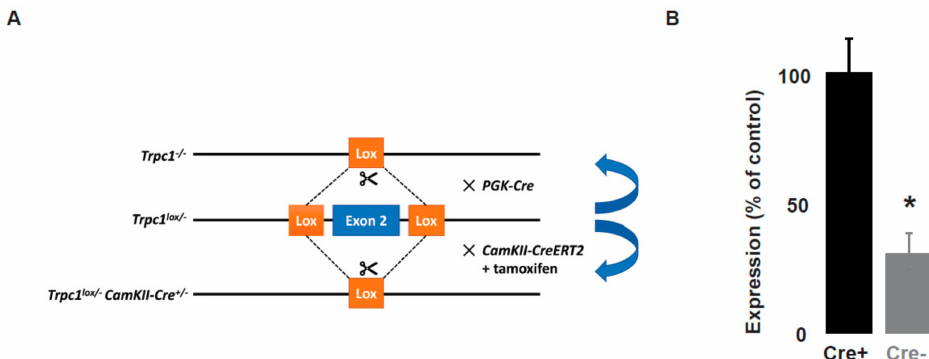
Figure 1. Generation of the Trpc1 conditional knockout mice. A . Mice having the second exon of Trpc1 gene flanked with loxP site (panel A, middle line) were bred either with the PGK-Cre recombinase mice line to obtain a constitutive Trpc1 knockout mouse line (panel 1, upper line) or with mice expressing the CreERT2 fusion protein under the control of the regulatory elements of the CaMKII α gene ( CaMKII-CreERT2 transgene, panel 1, bottom line) to obtain Heterozygous transgenic mice ( Trpc1 lox / − CaMKII Cre +/ − mice) (panel A, bottom line). B . Trpc1 expression measured by RT-qPCR analysis in hippocampal samples from Trpc1 lox / − CaMKII Cre +/ − and Trpc1 lox / − CaMKII Cre − / − mice 10 days after the last IP injection of tamoxifen. *: p < 0.05, Student’s t -test, n = 9 samples of hippocampus from three di ff erent mice for each genotype (i.e., 3 independent